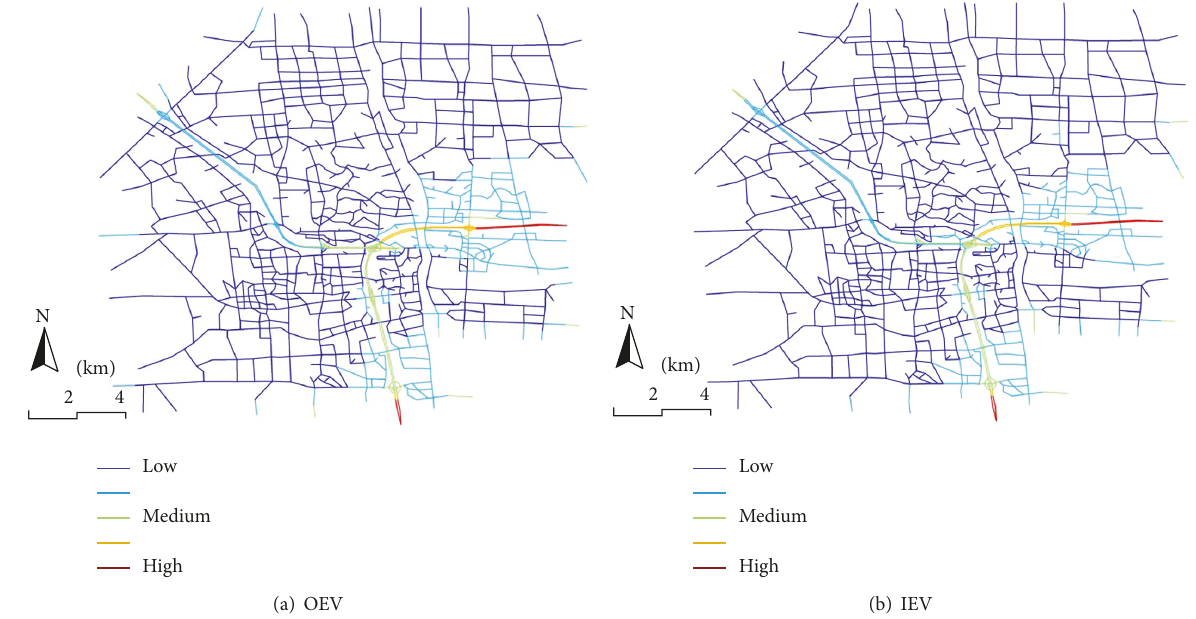
Figure 4: The evacuation vulnerability in the study area for (a) evacuees and (b) first responders (search boundary = 20